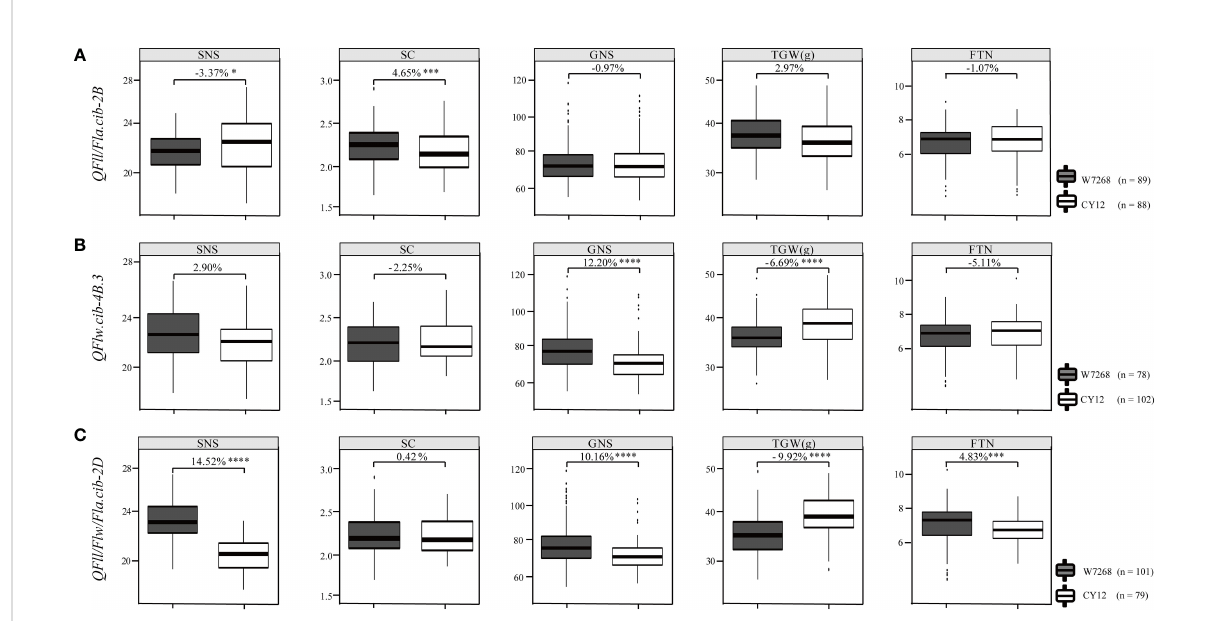
FIGURE 5 Effects of QFll/Fla.cib-2B (A) , QFlw.cib-4B.3 (B) , and QFll/Flw/Fla.cib-2D (C) on spikelet number per spike (SNS), spikelet compactness (SC), grain number per spike (GNS), thousand grain weight (TGW), and fertile tiller number (FTN) in WC12 population. W7268 and CY12 represent lines with alleles from W7268 and CY12, respectively; *, ***, and **** represent signi fi cant at P < 0.05, P < 0.005, and P < 0.001,